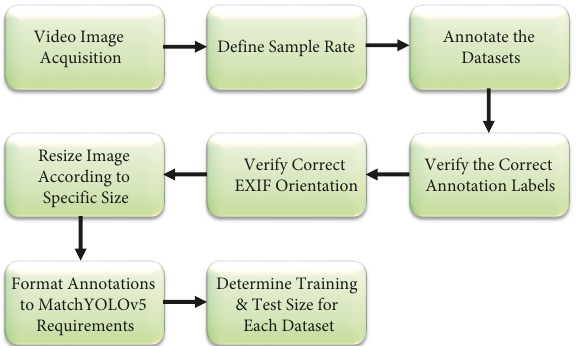
Figure 4: Overview of the process and implementation of data